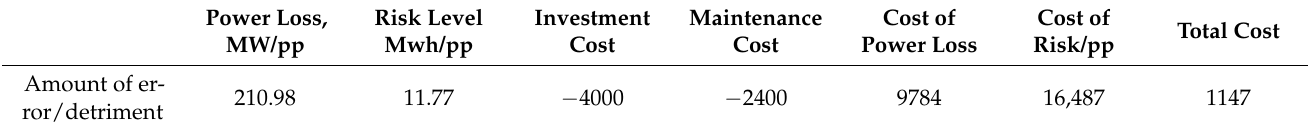
Table 9. Distribution feeder failure